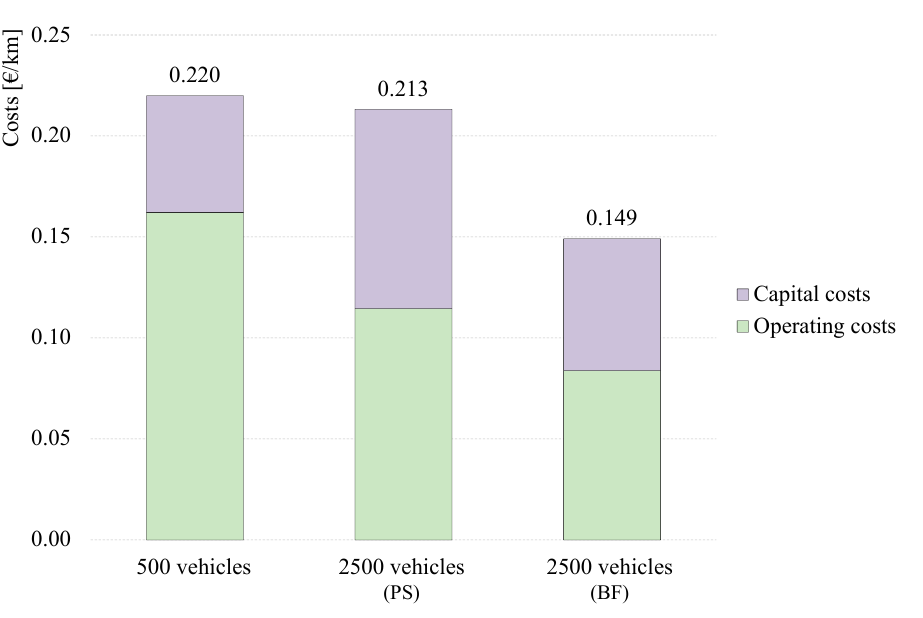
Figure 7. Total cost per kilometer of e-moped fleets of additional scenarios (PF—personal factor, BS—8 h battery